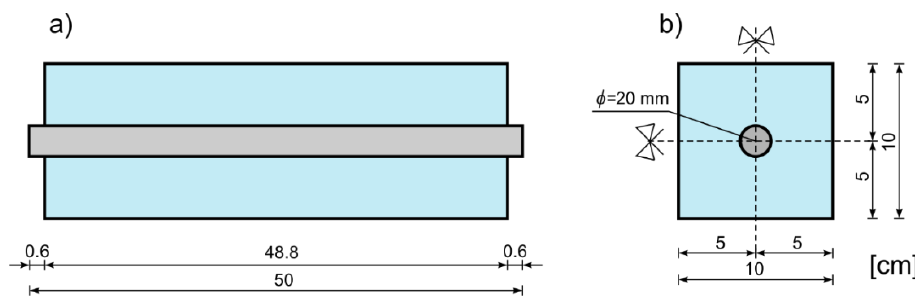
Figure 6. Geometry of the investigated beam: ( a ) Dimensions of the specimen, ( b ) geometry of the cross-section.